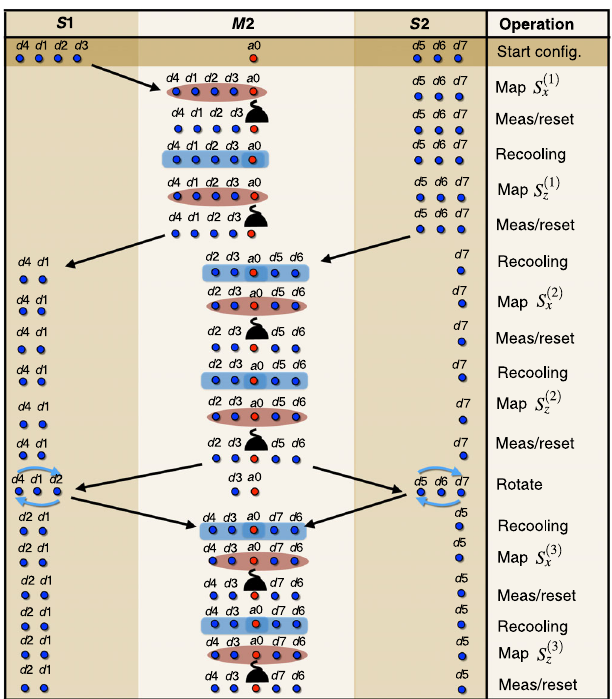
FIG. 18. Real-space representation of shuttling-based, two- species QEC cycle with multi-qubit MS gates: We use the same conventions as in Fig. 15. As announced in the main text, the number of crystal reconfigurations is reduced with respect to the shuttling-based one-species protocol. In the rightmost column, we specify the times when crystal rotations, stabilizer mappings, ancillary measurements, and the new sympathetic (Recooling), represented by blue rectangles, are applied.